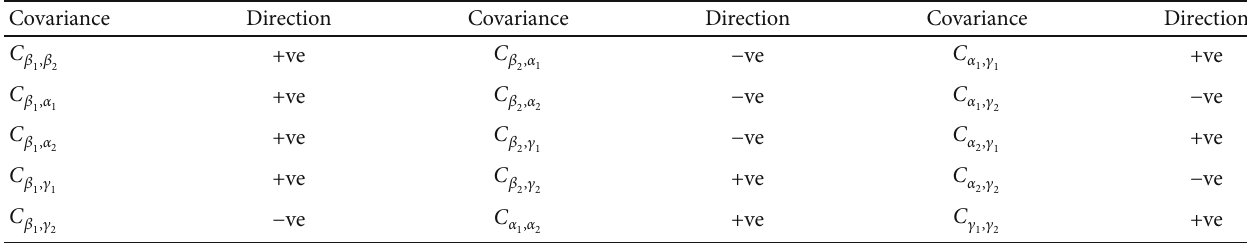
Table 6: Summary of